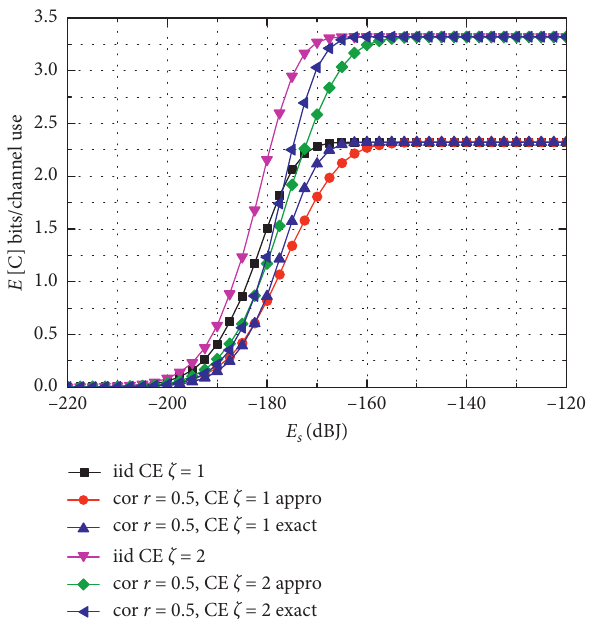
Figure 8: Theoretical and approximate ergodic channel capacity with different number of “on” slots.